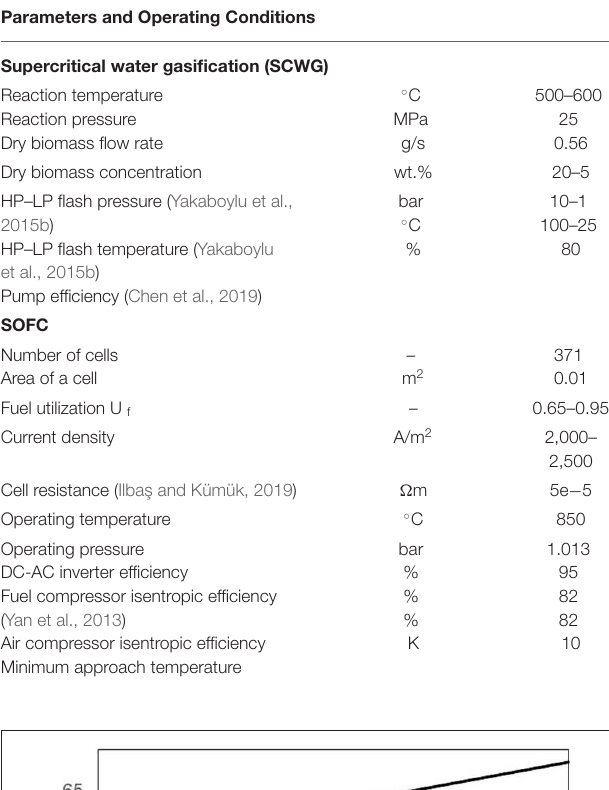
TABLE 4 | Gasifier and solid oxide fuel cell (SOFC) stack parameter and operating conditions.